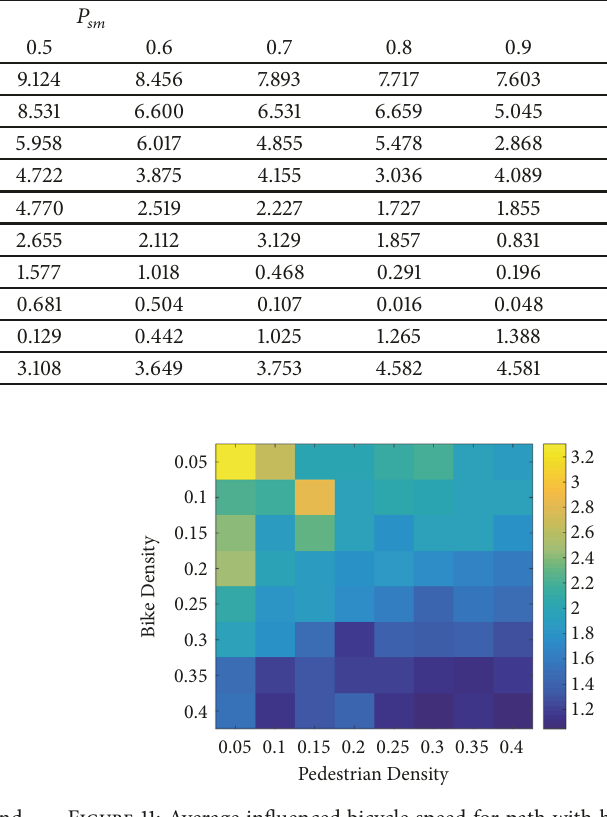
Figure 11: Average influenced bicycle speed for path with harbor- shaped bus stop.